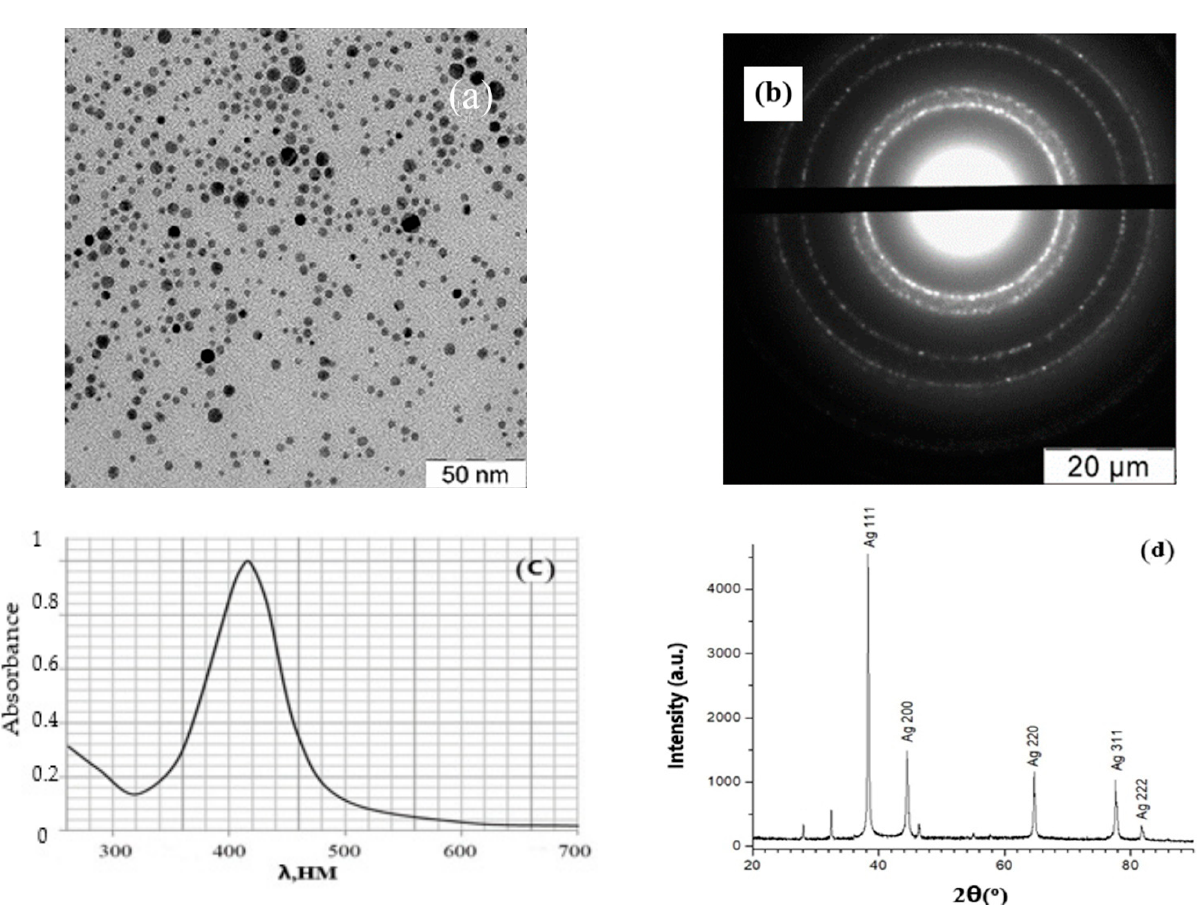
Figure 1. Electron micrographs ( a ), electron microdiffraction ( b ), absorption spectrum in the visible region ( c ), and data of X-ray phase analysis ( d ) of silver NPs stabilized by PHMB used during the field